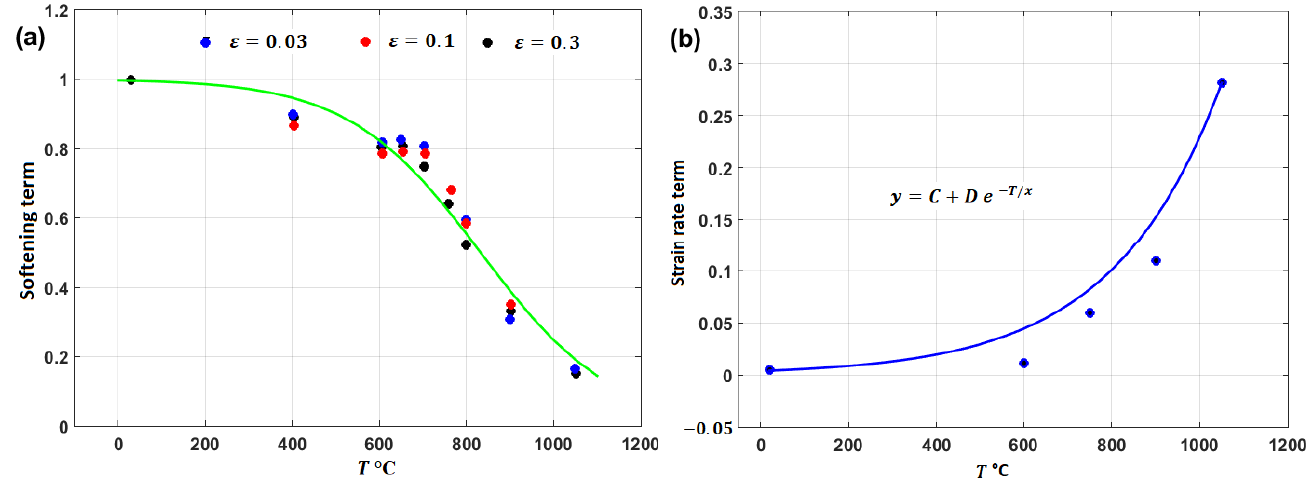
Figure 35. Exponential fitting of temperature with ( a ) the thermal softening term and ( b ) the strain hardening term.